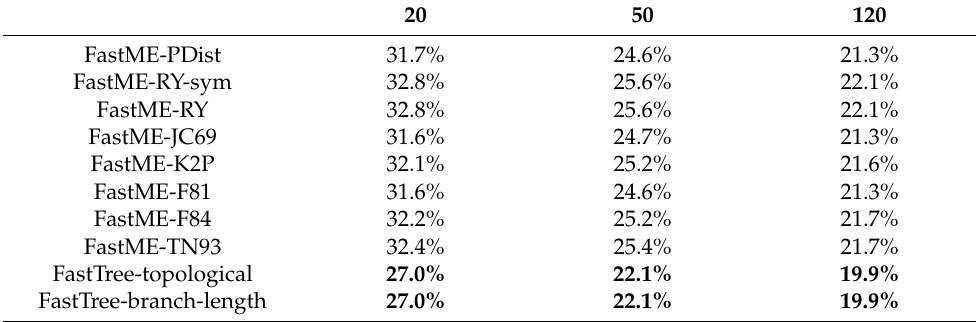
Table A3. Experiment 1: Impact on TreeMerge tree error (FN) rates from varying the distance matrix calculation technique and maximum subset size on the Cox1-HET datasets. The starting tree is computed using FastTree, the constraint trees are computed using IQ-TREE, and constraint trees are merged using TreeMerge with PAUP* branch lengths, using a distance matrix computed using one of the selected techniques. K20, F81, F84, and TN93 refer to distance calculations based on statistical models of sequence evolution; PDist refers to the p-distance between sequences (i.e., fraction of the alignment where two sequences differ); RY coding refers to coding all purines (A or G) as Rs and all pyrimidines (C or T) as Ys; and the remaining two (FastTree-topological and FastTree-branch-length) are distances produced using the FastTree guide tree. The most accurate results for each maximum subset size are boldfaced. 20 50 120 FastME-PDist 31.7% 24.6% 21.3% FastME-RY-sym 32.8% 25.6% FastME-RY 32.8%